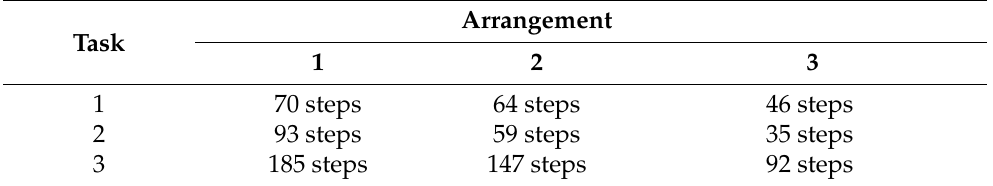
Table 4. Steps required to complete three reaching tasks using three arrangements of control points.